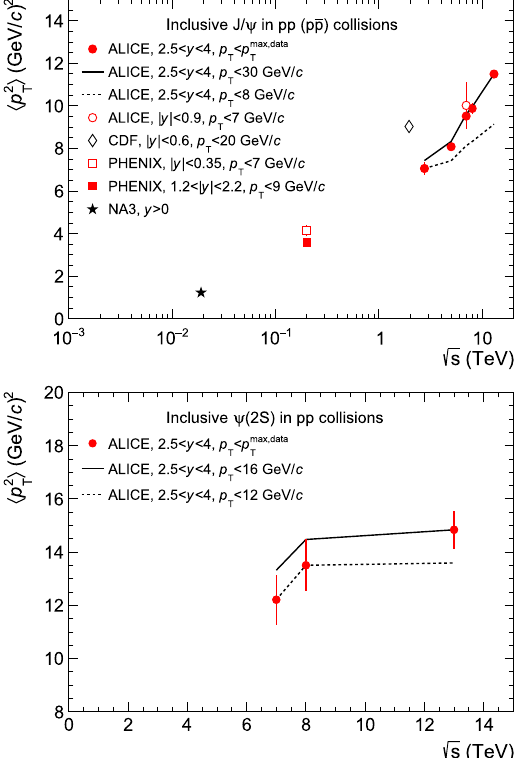
√ s for J /ψ ( top ) to calculating (cid:3) p t (cid:4) and (cid:3) p 2 t (cid:4) when extrapolating the p t coverage to the largest available range in ALICE data (0 < p t < 30 GeV/ c for √ s . Vertical lines J /ψ and 0 < p t < 16 GeV/ c for ψ( 2S ) ), while the dashed lines correspond to truncating the data to the smallest p t range available (0 < p t < 8 GeV/ c for J /ψ and 0 < p t < 12 GeV/ c for ψ( 2S ) )